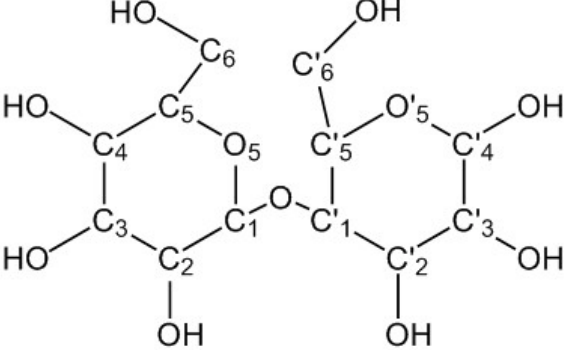
Figure 1. The labeling diagram of cellobiose.